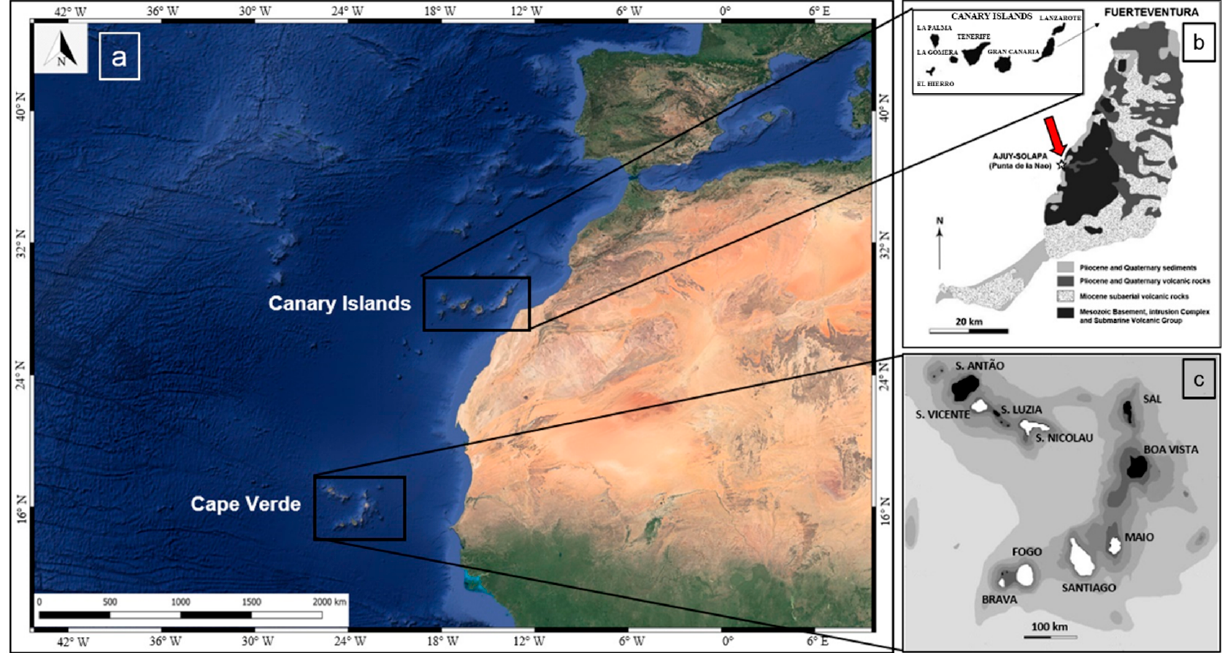
Figure 1. ( a ) Canary Islands and Cape Verde Archipelago in their geographic contest. ( b ) Simplified geology map of Fuerteventura showing the location of the carbonatite-studied samples (red arrow) (modified from Sagan et al. 2020 [65]) and ( c ) detail of the Cape Verde Archipelago, where the islands on which carbonatites are present are shown in white (modified from Mata et al. 2010 [23]).